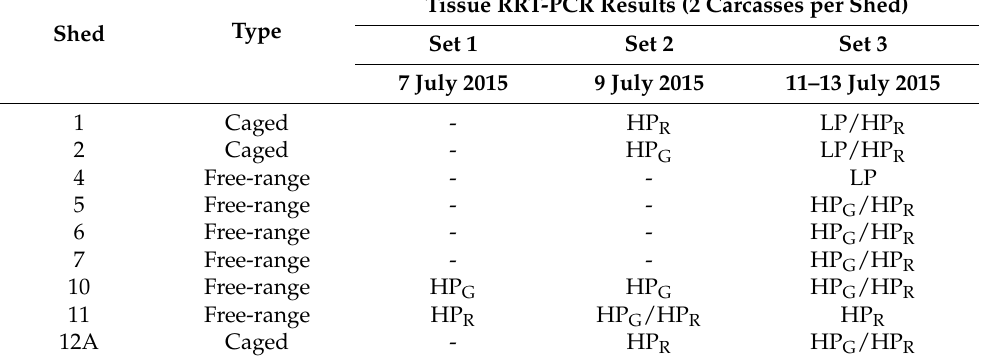
Table 4. Summary of the HA CS motifs detected across Sample Sets 1, 2, and 3. HA CS motifs for each shed were determined based on sequencing of individual swabs, pooled tissues, or viral